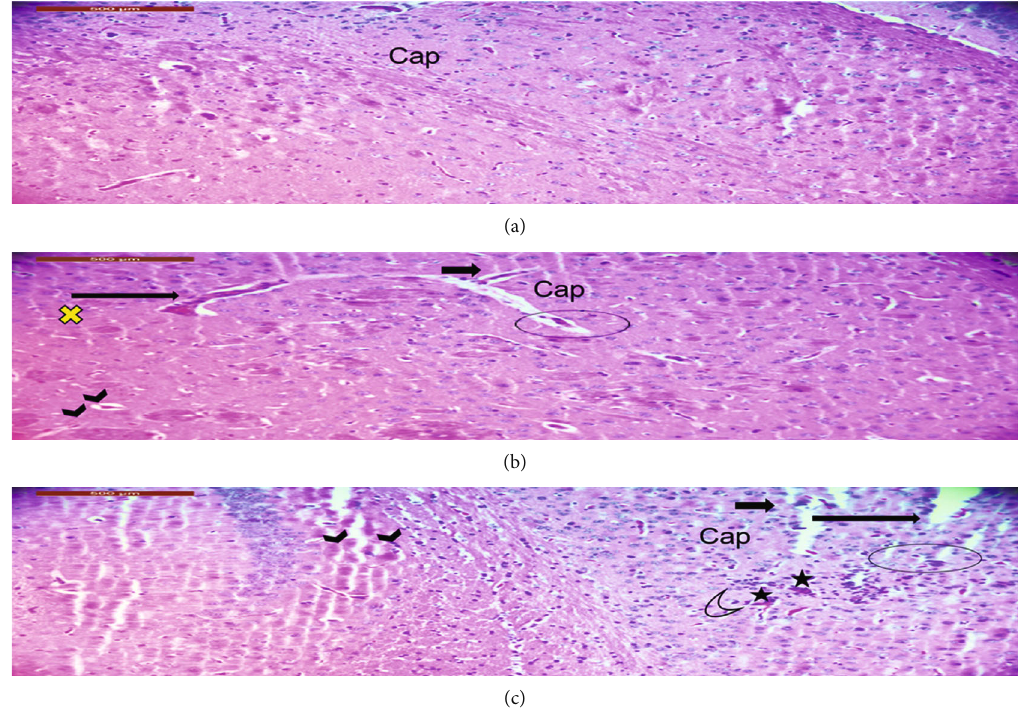
Figure 3: Histological fi ndings of brain tissues stained with hematoxylin-eosin (HE) in rats using light microscopy. (a) The normal (control group) rat brain showed a uniform and normal arrangement and structure of cerebral capillaries (capillary structure, Cap) and blood vessels with normal con fi guration. (b) The L group (low13-RA dose) showed an increase in glycolipids (yellow x sign), congestion of cerebral blood vessels (short wide small arrow), and focal hemorrhage (long arrow). The hippocampal neurons were reduced to ghost cells, with no nuclear staining and a barely visible cell outline plus softening and hemorrhage (chevron arrows). (c) The H group (high dose) showed necrosis of neurons (small stars), neuronophagia (small circles), and neuronal edema (small crescent shape). Subarachnoid hemorrhage was also